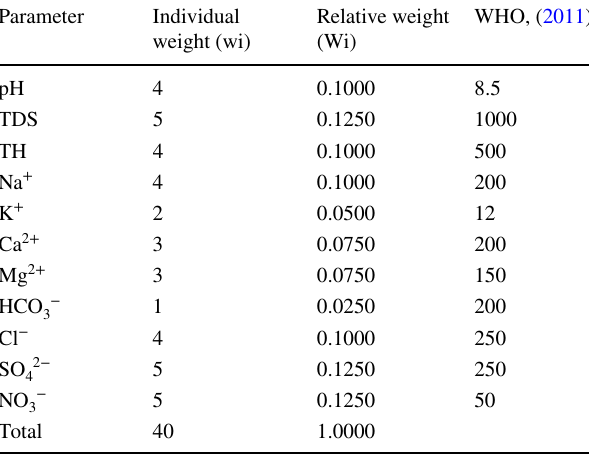
Table 1 Individual weight and relative weight of the parameters to calculation of